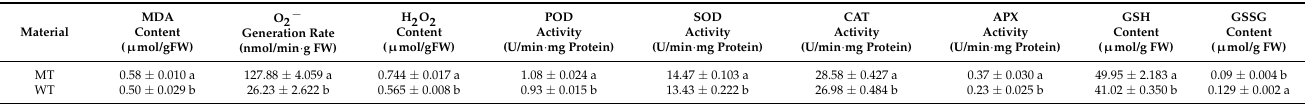
Table 1. Values of malondialdehyde (MDA), hydrogen peroxide (H 2 O 2 ), reduced and oxidized glutathione (GSH and GSSH) content, superoxide anion (O 2 − ) generation rate and superoxidase dismutase (SOD), peroxidase (POD) and catalase (CAT) activity in leaves of mutant (MT) and wild- type plants